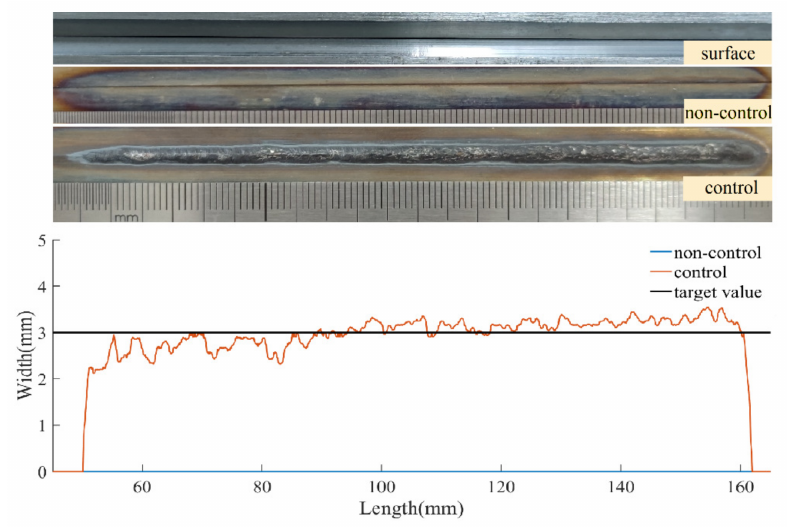
Figure 8. Comparison of results of the bottom molten pool width of butt welding with a groove angle of 45 ◦